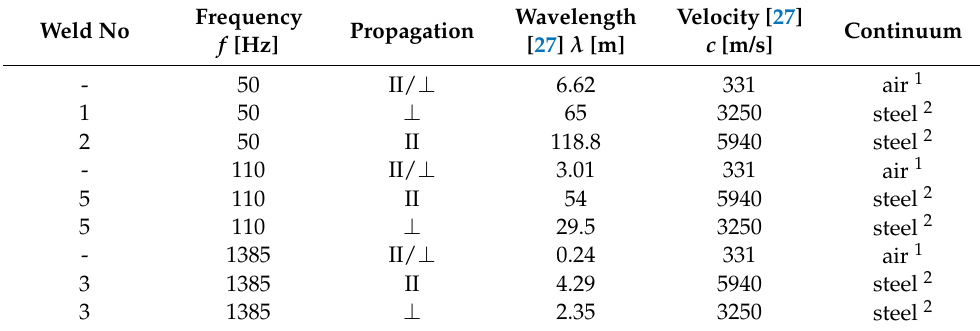
Table 1. Material and characteristic parameters of vibrations supporting laser welding. Weld No